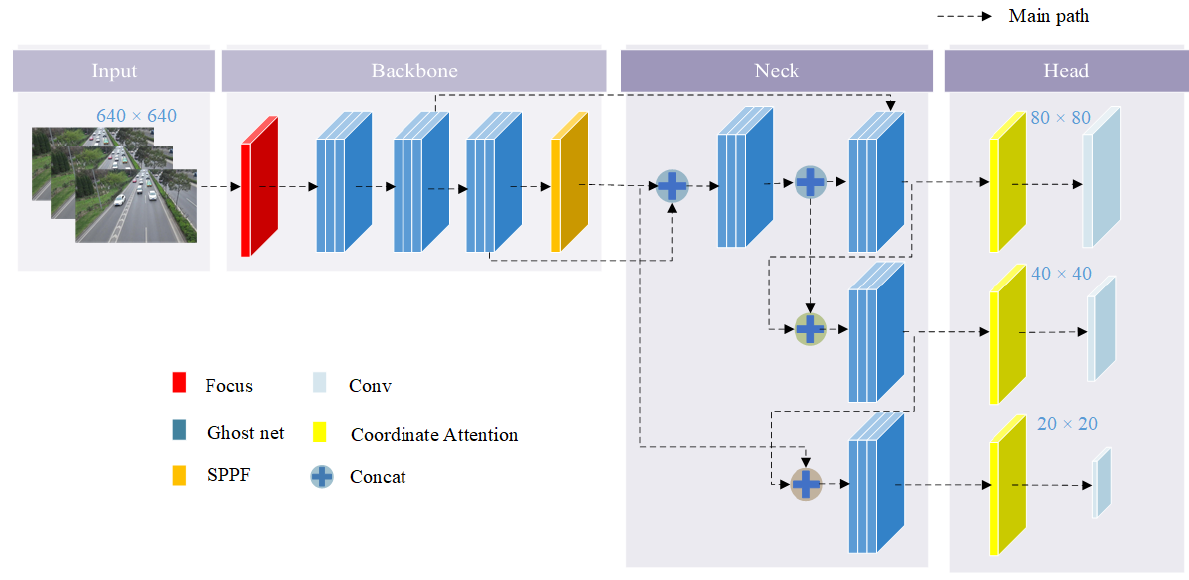
Figure 6. YOLOv5_N network structure.